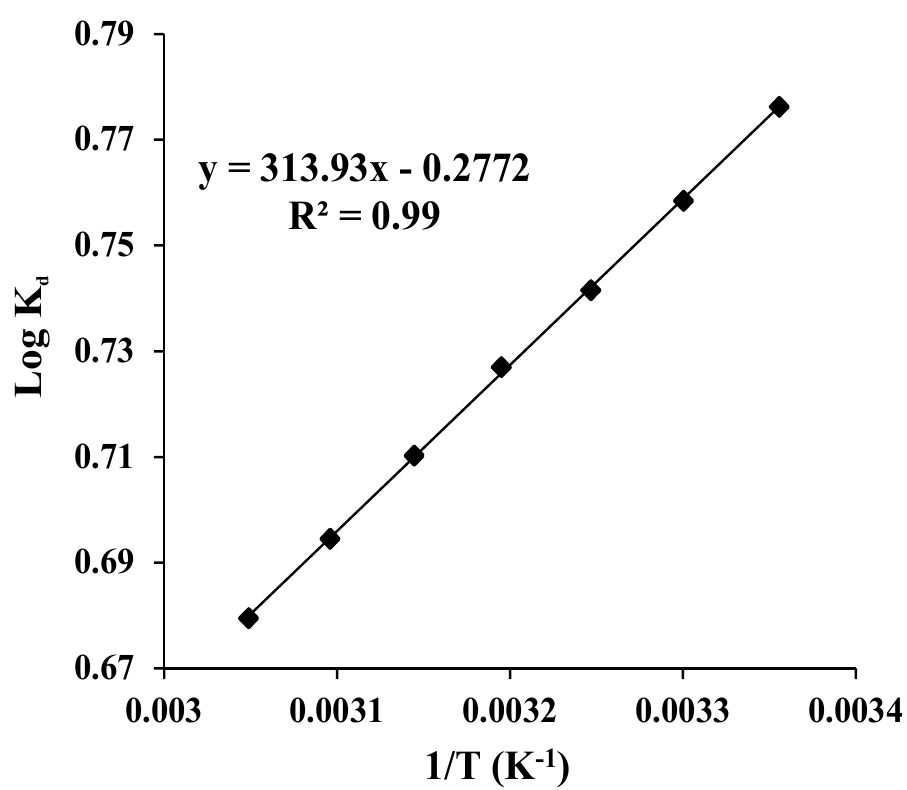
Figure 4. Graph of log K d versus 1/T for Y(III) adsorbed on the AHIBC adsorbent. Table 4. Thermodynamic parameters of the Y(III) adsorption on the AHIBC adsorbent. Temperature, K 298 K 303 K 308 K 313 K 318 K 323 K 328